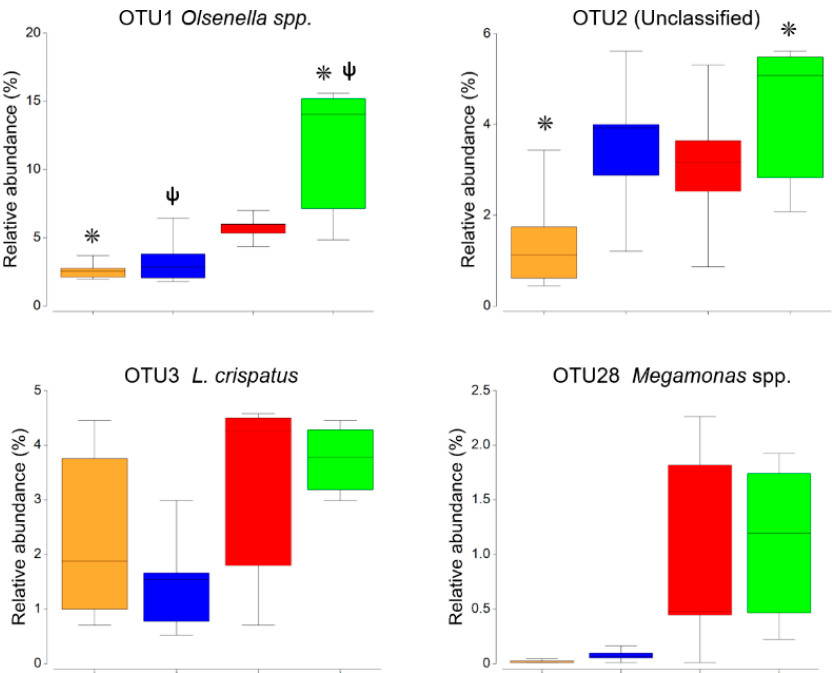
Figure 2. Box-plots with the relative abundance of the most abundant operational taxonomic units (OTUs). The color code indicates, yellow for control, blue for the probiotic, red for the prebiotic, and green for the synbiotic treatment. The symbols indicate statistical significance ( p ≤ 0.05).